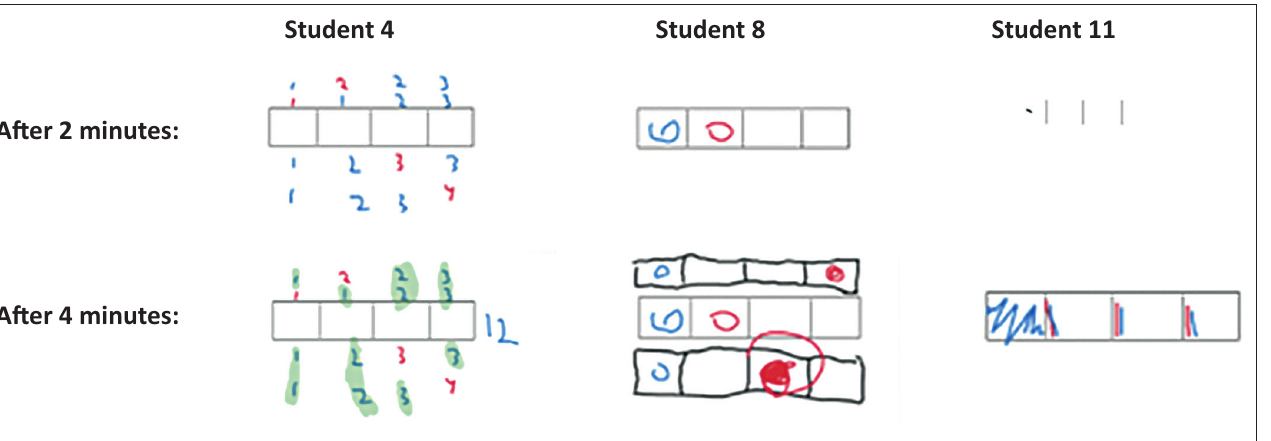
FIGURE 3: Screenshot of the work of Students 4, 8 and 11 at two and four minutes after the task is provided to